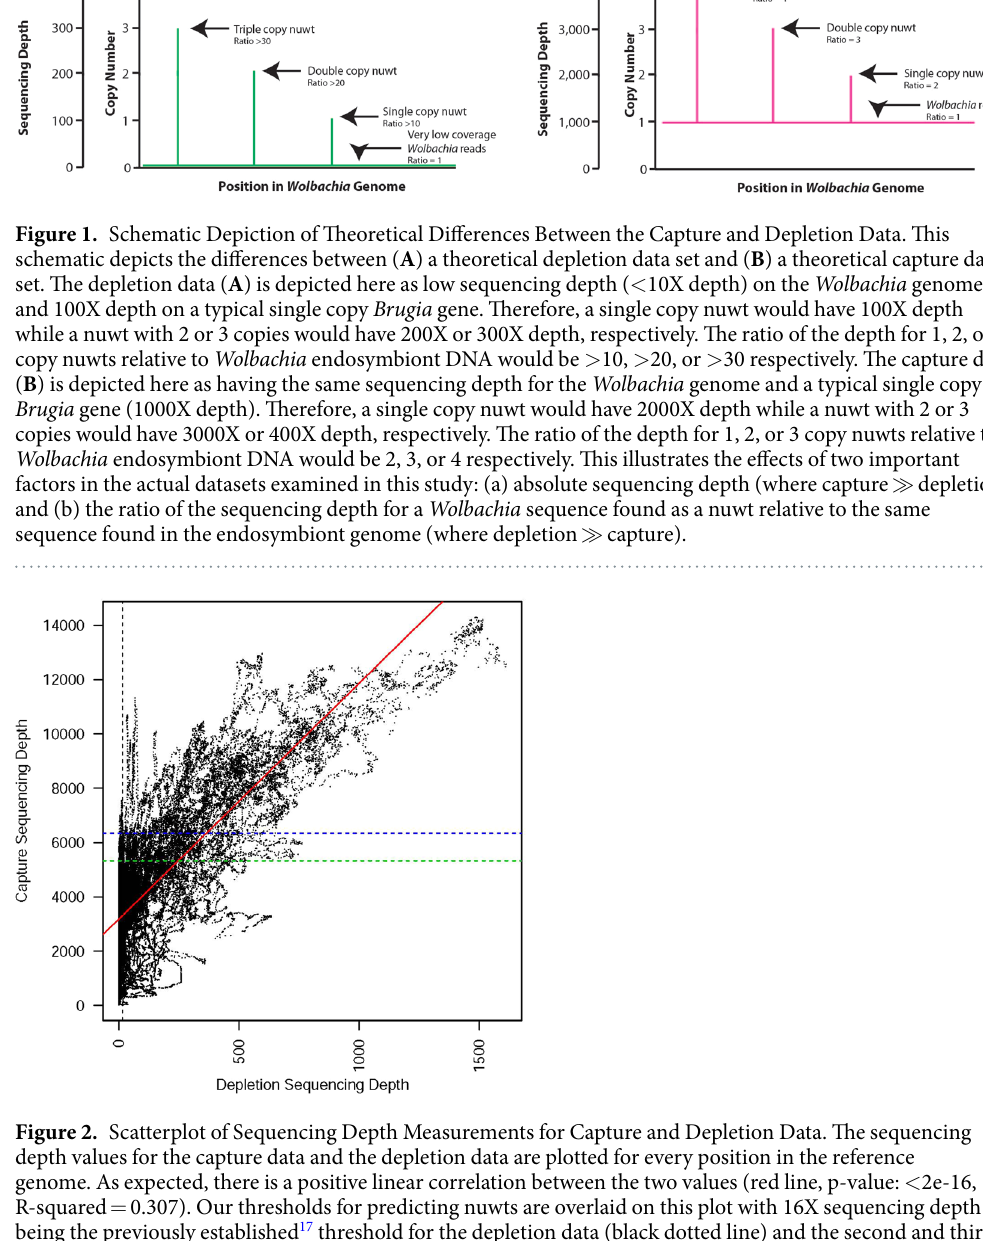
sequencing depth that correspond to nuwts and the height of the peak is expected to be proportional to the num- ber of copies of that nuwt (Fig. 1A). In the capture data we expect these peaks still occur, but they are added to a background sequencing depth from the reads derived from the Wolbachia endosymbiont genome (Fig. 1B). As a result of these two factors, the capture data has a much larger sequencing depth, but the antibiotic depletion of Wolbachia in the depletion data leads to higher ratio differences in sequencing depth. Despite these differences, the sequencing depth for each nt position in the w Bm genome correlates well between the capture data and the depletion data (Fig. 2, p-value: < 2e-16, R-squared = 0.307). Therefore, we expect that regions of increased sequencing depth in the capture data correspond to multiple copies of Wolbachia sequences present in the host’s genome as multi-copy nuwts. While a correlation is observed between the sequencing depth values for the capture data and those for the depletion data, as described above, such a correlation does not necessarily imply that sequencing depth can accu- rately predict nuwts. There are three factors that will influence the ability to predict nuwts using the capture